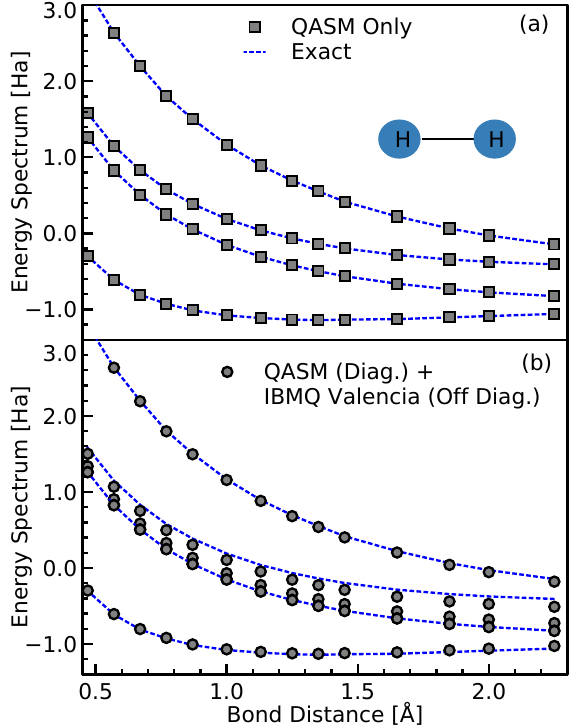
Figure 6. The binding curves for H 2 using a ( a ) noiseless QASM simulator to obtain all Pauli terms and ( b ) a noiseless QASM simulator to evaluate diagonal Pauli terms and the IBMQ Valencia 5-qubit device to measure off-diagonal